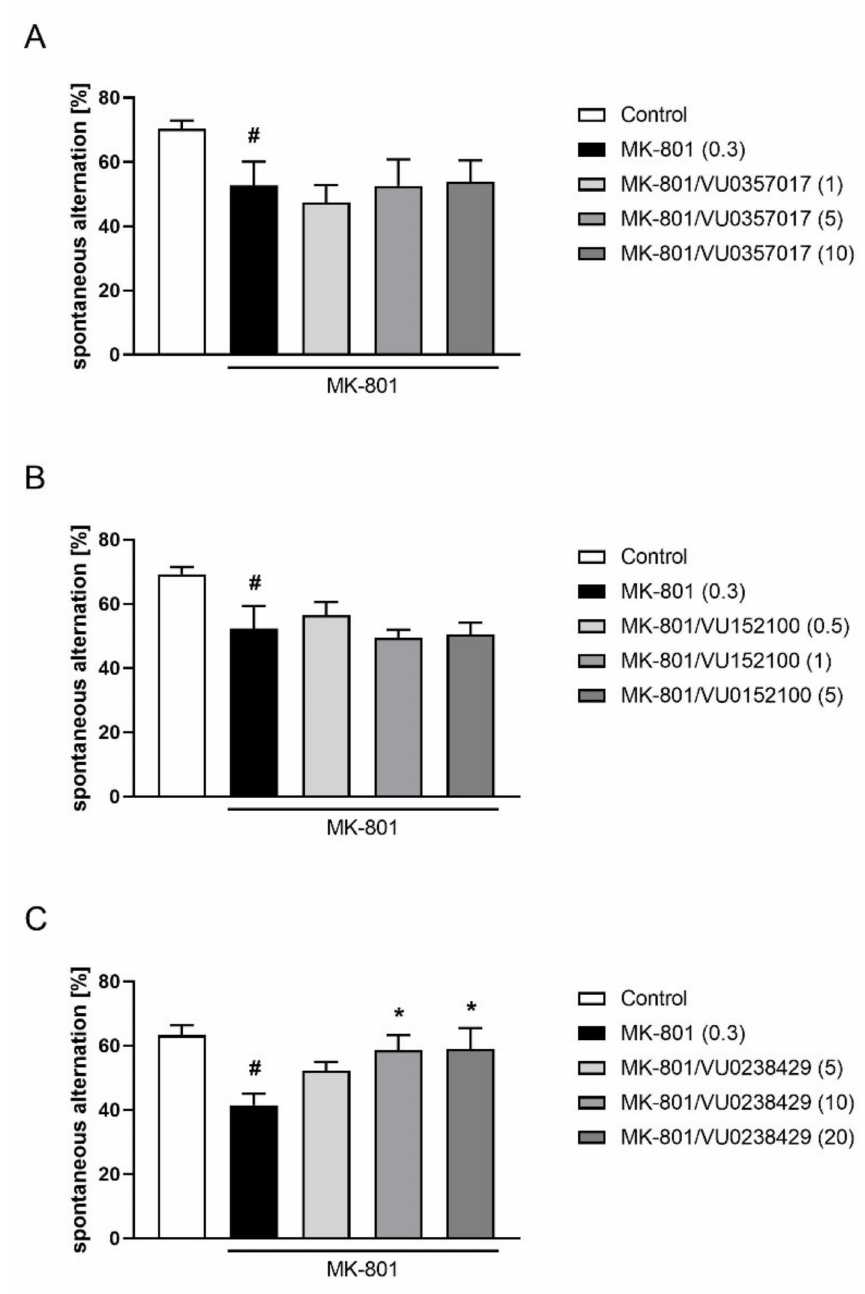
Figure 4. Activity of VU0357017 ( A ), VU0152100 ( B ), and VU0238429 ( C ) in the Y-maze test. The data are presented as means ± SEM. Doses of the compounds are indicated in parentheses. # p < 0.05 ( A , B ) or # p < 0.001 ( C ) compared to control animals and * p < 0.05 compared to MK-801-treated